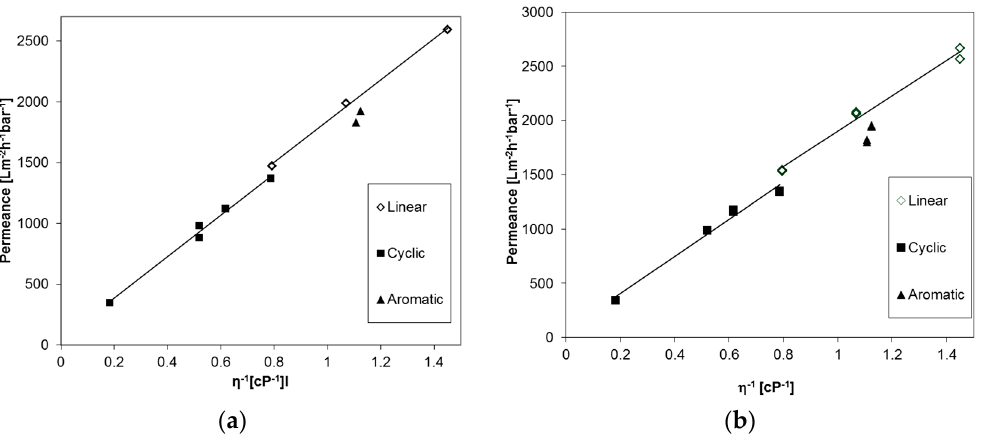
Figure 4. Permeances of Anodisc ® membrane with 20 nm pore diameter ( a ) and PE membrane with 50 nm pore diameter ( b ) against reciprocal dynamic viscosity of linear, cyclic aliphatic and aromatic PF compounds.